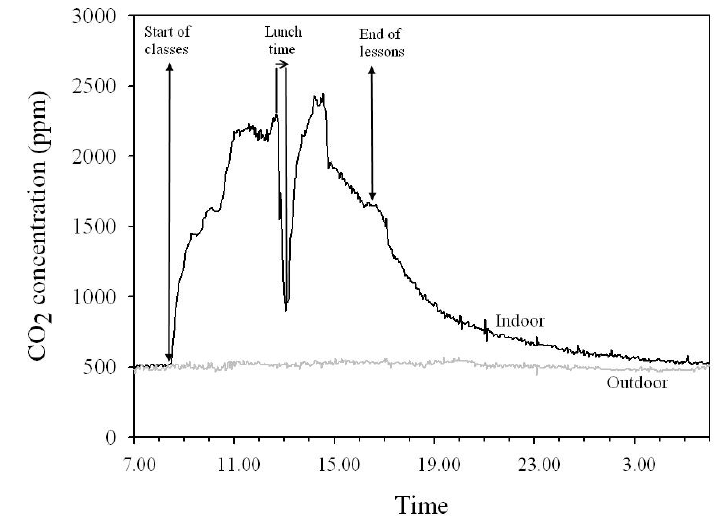
Figure 6. Typical daily indoor variation in CO for one monitored